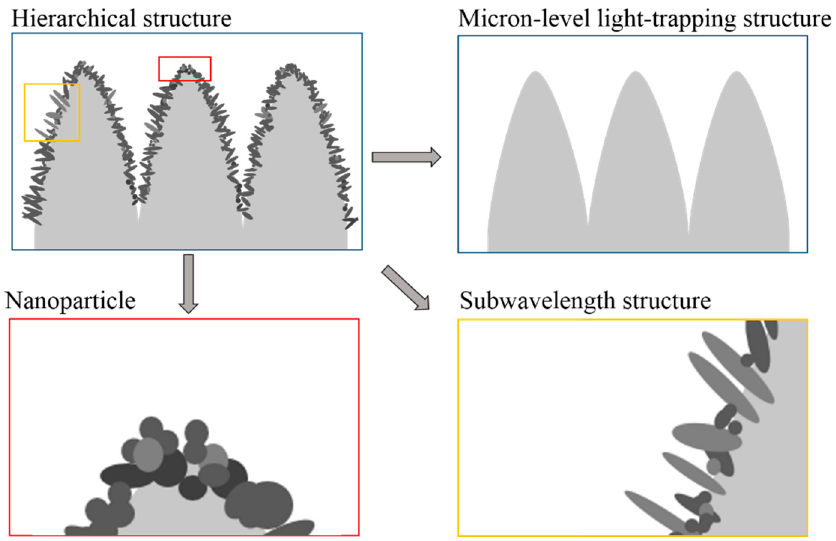
Figure 2. Schematic illustrations of hierarchical structure.